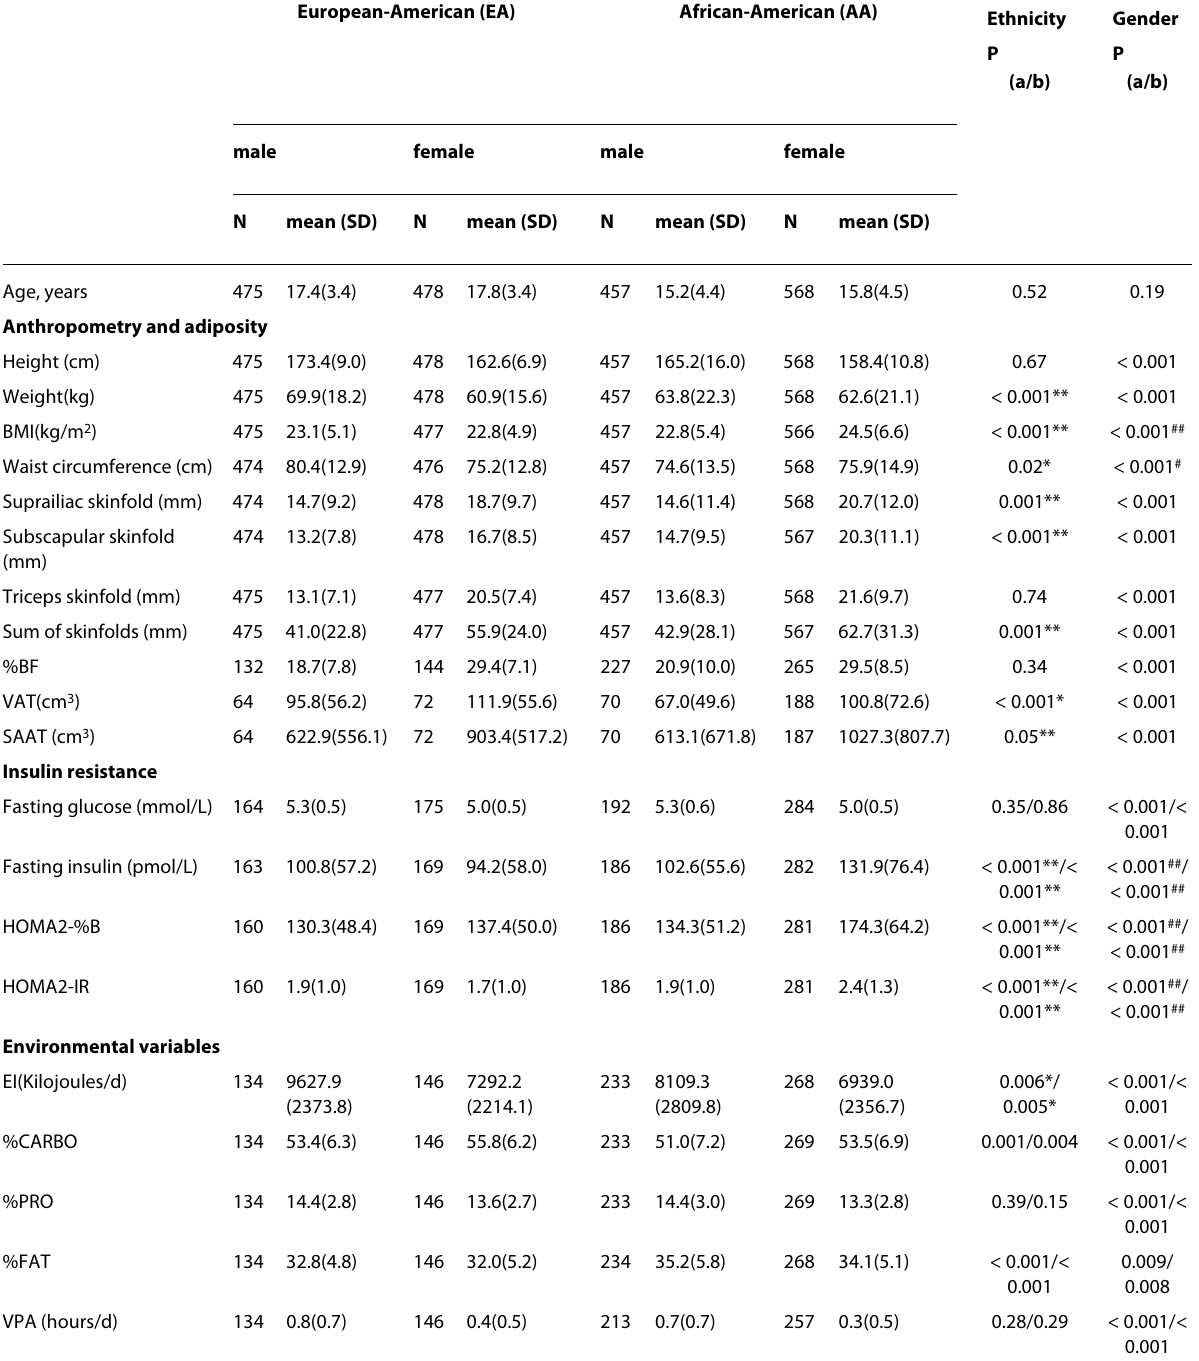
Table 1: General characteristics of study subjects European-American